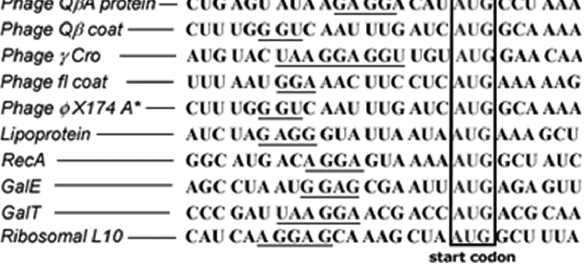
Figure 2 - Selected parts of the E. coli genome. The RBS sequences are underlined, and the names of the genes they correspond to are on the left. Adapted Figure from Alberts (1994) page 401.